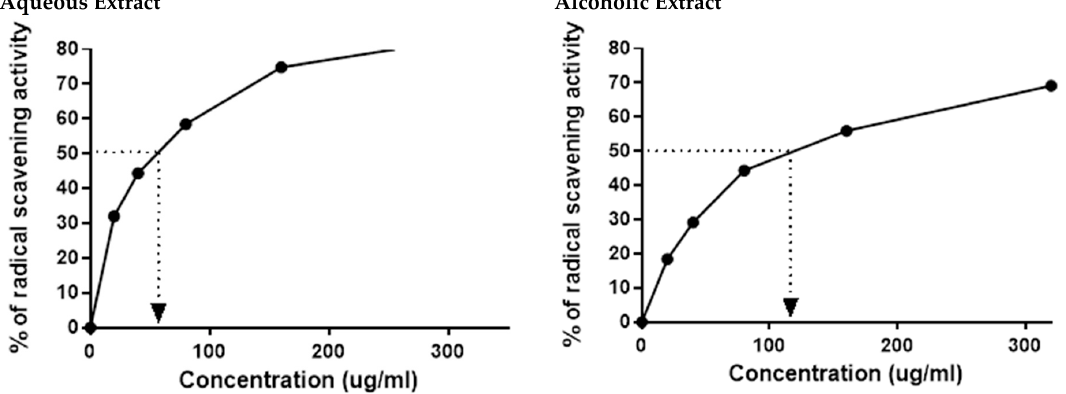
Figure 2. DPPH radical scavenging activity of 5% aqueous and alcoholic larval extracts shows their IC 50 values (52.67 ± 2.38 and 123.50 ± 4.62 µ g/mL, respectively). Values are mean ± SEM. Samples were run in triplicate in three independent experiments, n =